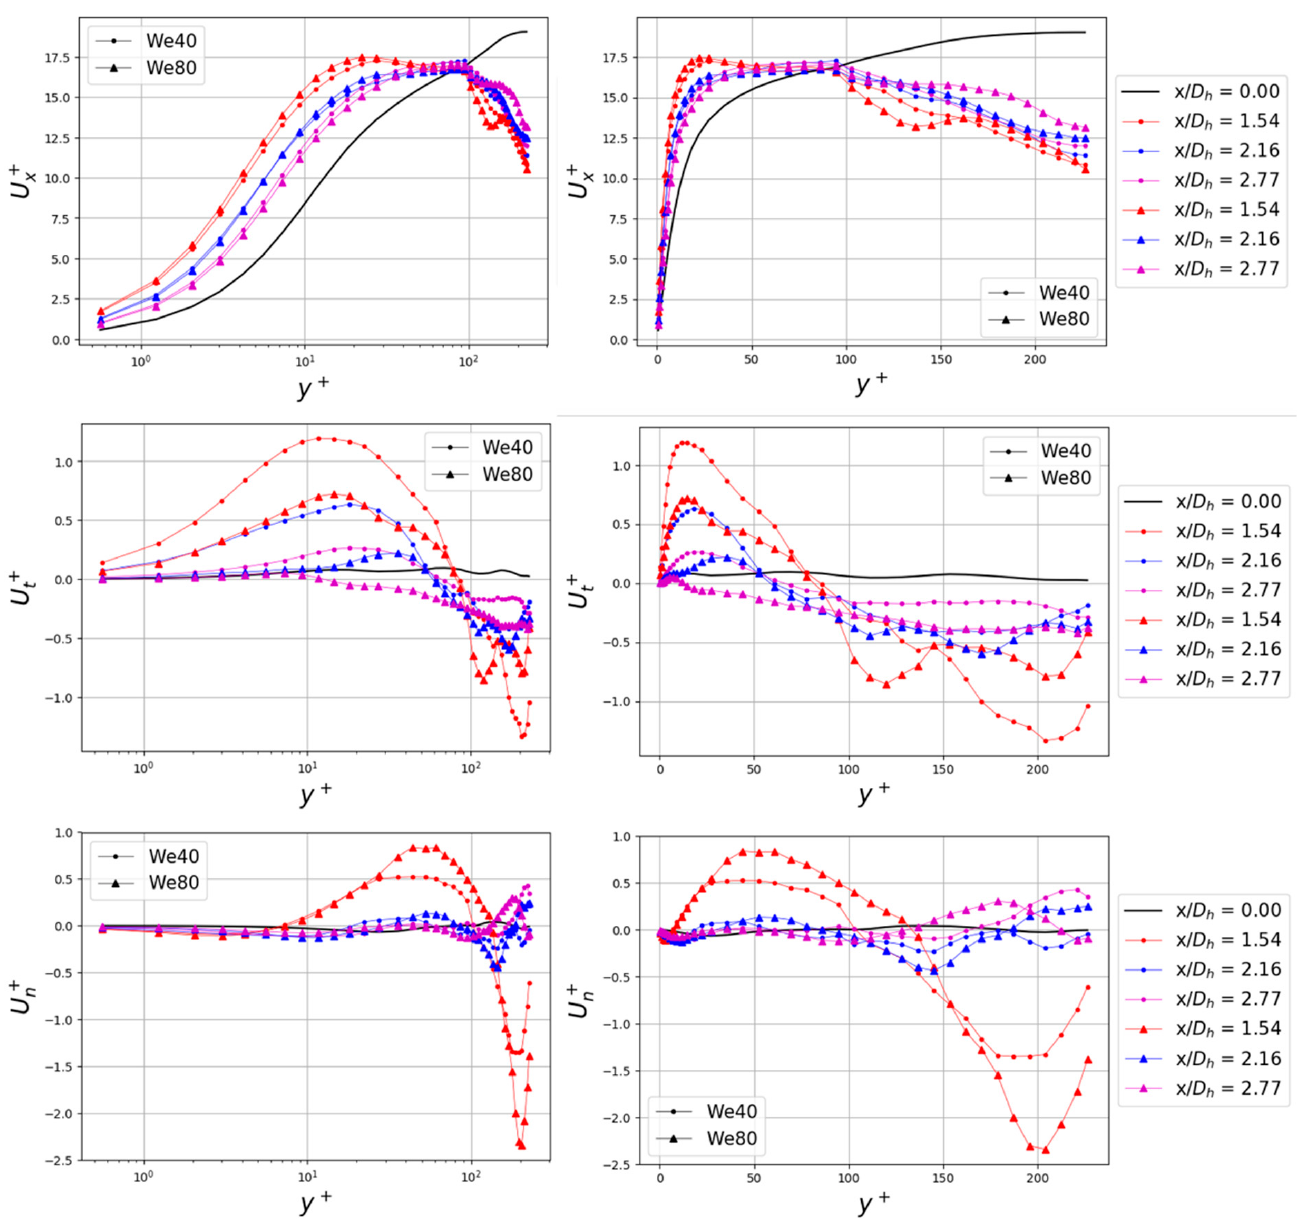
Figure 8. Comparison of normalized mean velocity components for the We40 and We80 cases. Profiles at three downstream probe planes are shown (lateral coordinates rotated to 𝑡 − 𝑛 ).